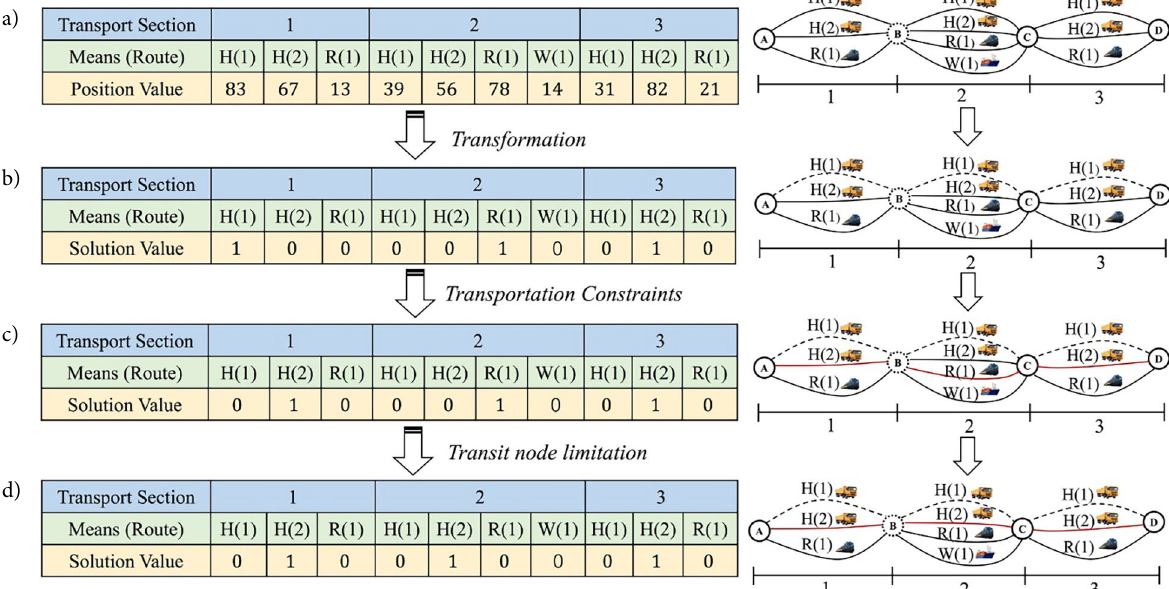
Figure 4. Transformation of the particle-represented solution to the